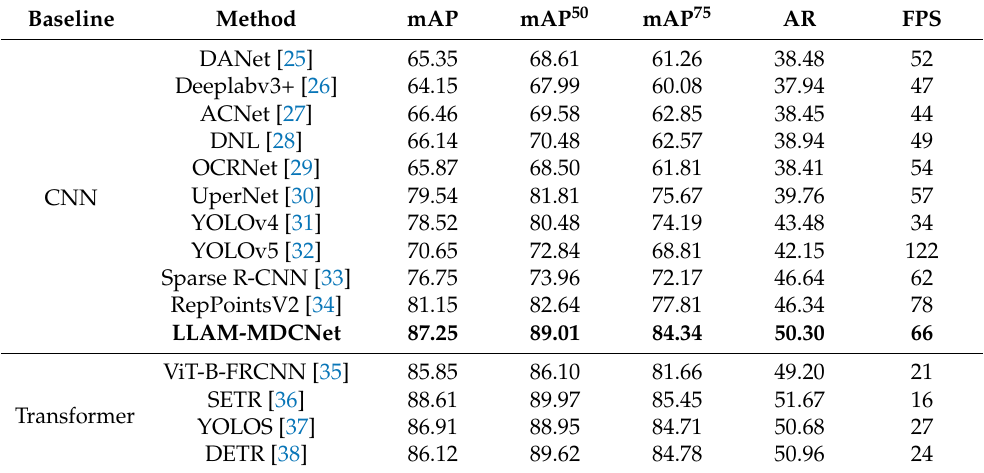
Table 3. Comparison experiment between LLAM-MDCNet and SOTA